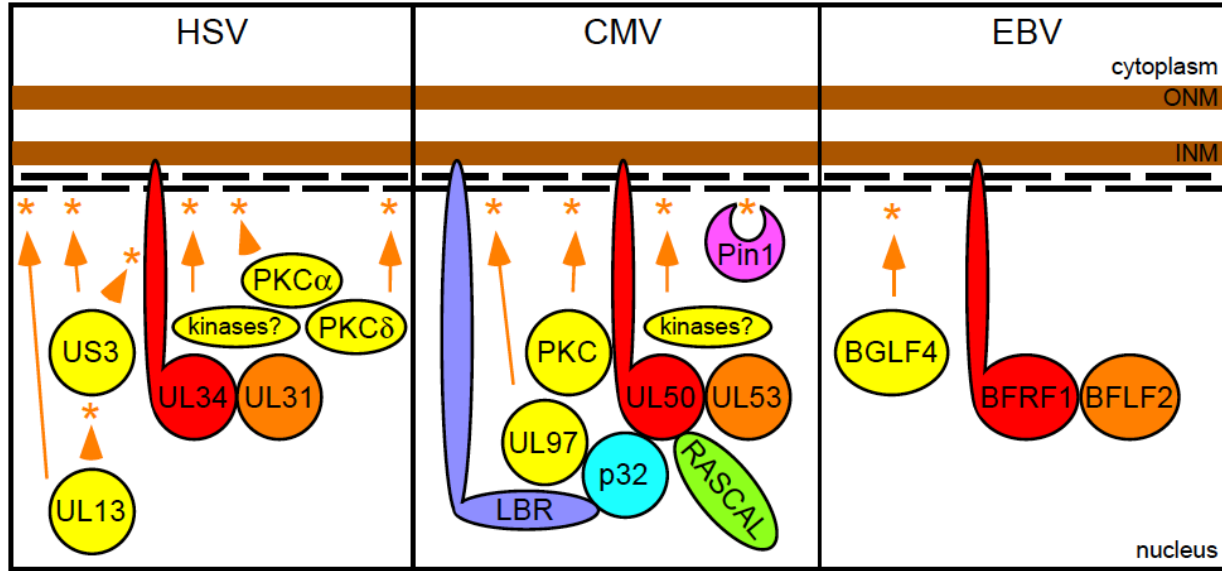
Figure 2. Herpes simplex virus 1 (HSV-1), cytomegalovirus (CMV) and Epstein-Barr virus (EBV) nuclear egress complex components and their interactions with the nuclear lamina. The two brown and thick lines represent the nuclear envelope, while the short black thin lines depict the lamin A/C and lamin B proteins comprising the nuclear lamina. Asterisks represent phosphorylation events performed by kinase proteins, whose names are contained in yellow-colored circles or ovals linked to the asterisks by orange arrows or arrowheads. The names of the two viral proteins composing the core of each nuclear egress complex (NEC) are contained within red- or orange-colored